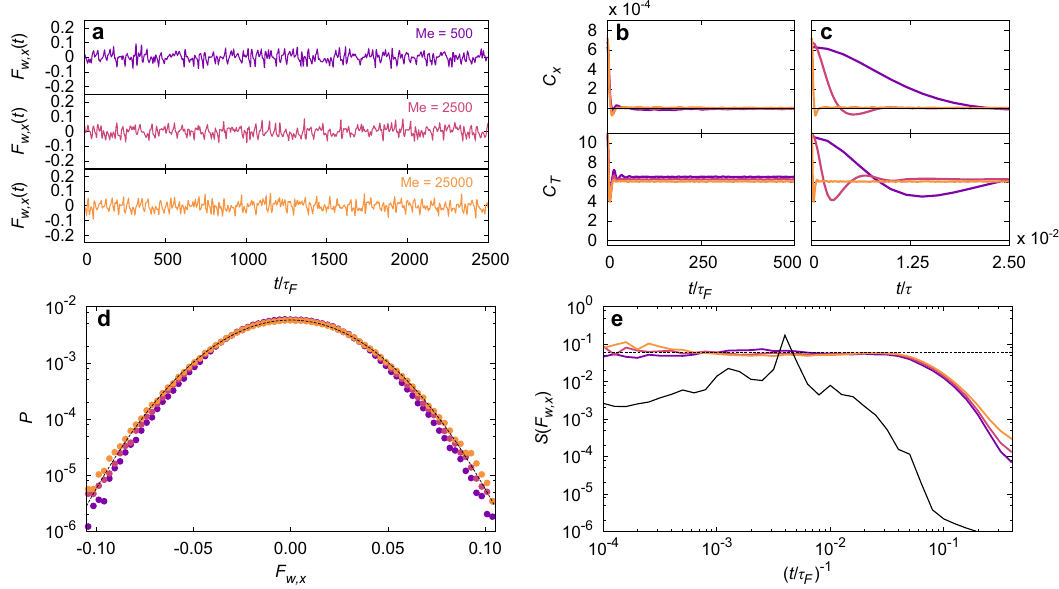
Fig. 3 The wave fi eld acts as a thermal reservoir for the walker. a Numerical time series of the wave force along the x direction, F w , x , for different values of the memory parameter Me and the same frequency ω /2 π = 0.25 Hz. From top to bottom the memory parameter is Me = 500, 2500 and 25,000 (purple, red and orange). b , c Numerical correlation functions for the wave force along the x direction, C x , (top) and along the direction tangent to the velocity, C T (bottom). The memory parameters and frequency are as in ( a ). Two points of view are presented. The time t is rescaled by ( b ) the bouncing time τ F and ( c ) by the memory time τ . d Numerical probability density function P for the wave force along the x direction on a semi-logarithmic scale. Parameters are as in ( a ). The solid gray curve is a Gaussian fi t to the data obtained at Me = 25,000. e Density power spectrum S for the wave force along the x direction on a double logarithmic scale. Parameters are the same as in ( a ). The dashed black line is a guide for the eyes and the black line indicates the density power spectrum in the low memory parameter regime, Me =